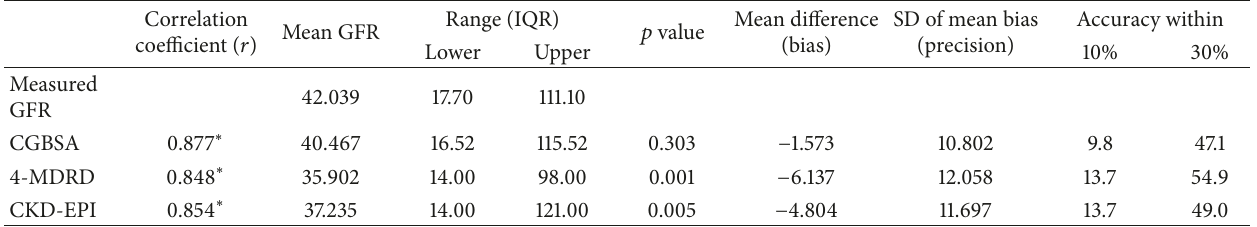
Table 3: Correlation coefficient ( 𝑟 ), mean, bias, precision, and accuracy for CGBSA, 4-MDRD, and CKD-EPI formula.